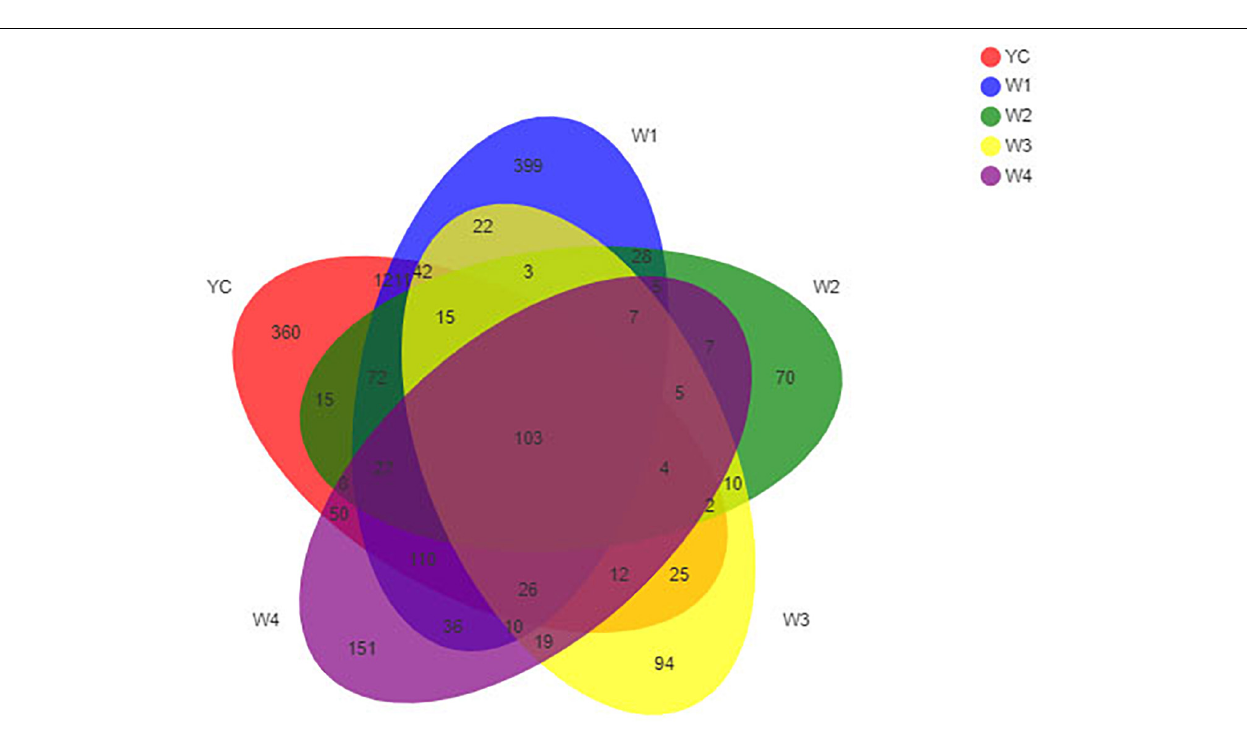
Frontiers in Microbiology |